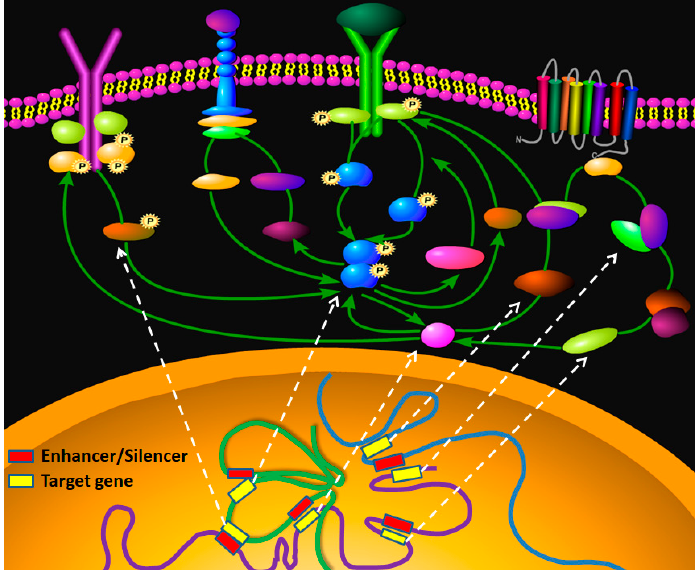
Figure 1. Schematic diagram of regulation networks of enhancers/silencers through higher-order chromatin struc- ture in cancer cells. Enhancers/silencers regulate target genes through higher-order chromatin structure and affect the expressions of proteins in signaling pathways and further function in cancer